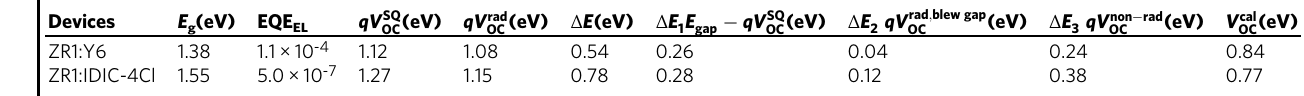
Table 2 Detailed V OC losses of the ZR1: Y6, ZR1: IDIC-4Cl-based OPV cells. Devices E g (eV) EQE